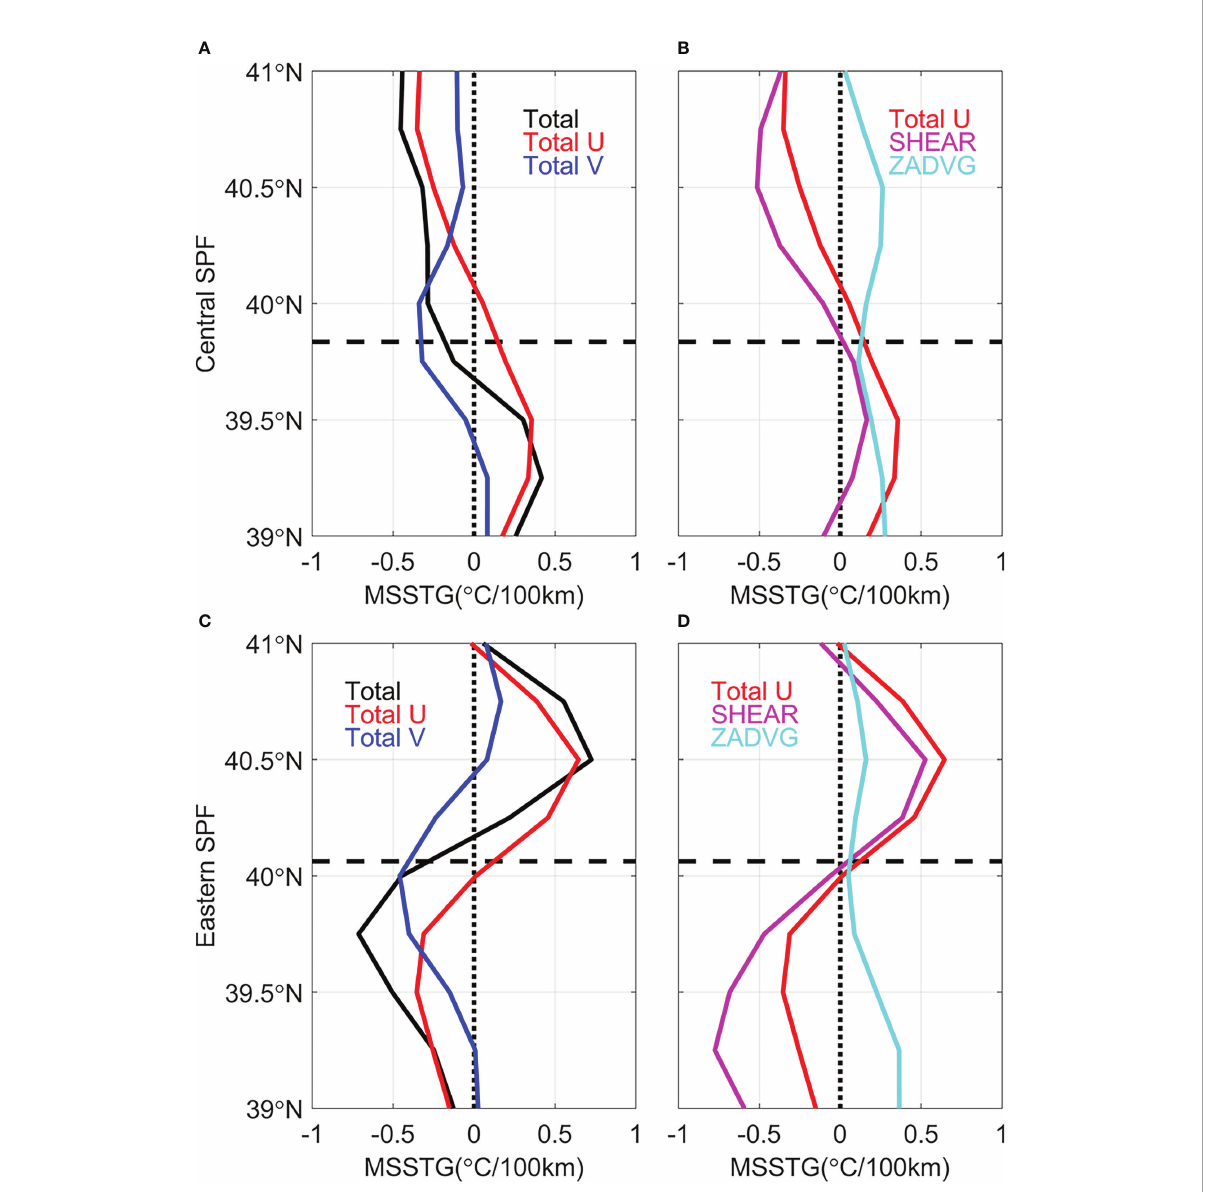
FIGURE 6 Zonal averaged decadal change in the MSSTG between 1993 – 2002 and 2011 – 2020 (the latter minus the former; unit: °C/100km) caused by the geostrophic advection term for (A, B) 130 – 135°E (central SPF) and (C, D) 135 – 138°E (eastern SPF). Black horizontal dashed lines represent main axis position of the SPF. Black vertical dashed lines represent 0 value. Black, red, blue, magenta and cyan solid lines indicate the decadal change in the MSSTG caused by the total geostrophic advection gradient term (Total), total zonal geostrophic advection gradient term (Total U), total meridional geostrophic advection gradient term (Total V), zonal shear advection term (SHEAR) and zonal advection of the MSSTG term